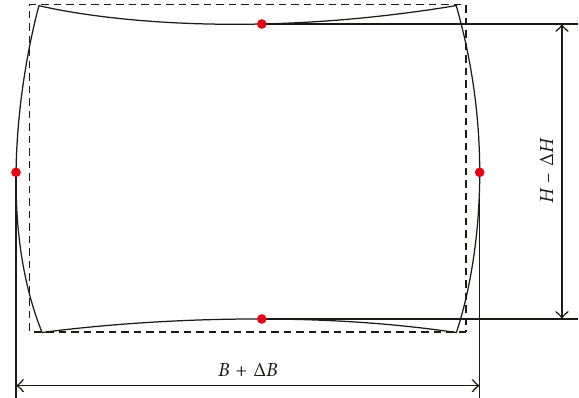
Figure 10: Distortion map of the cross section. Table 3: Range